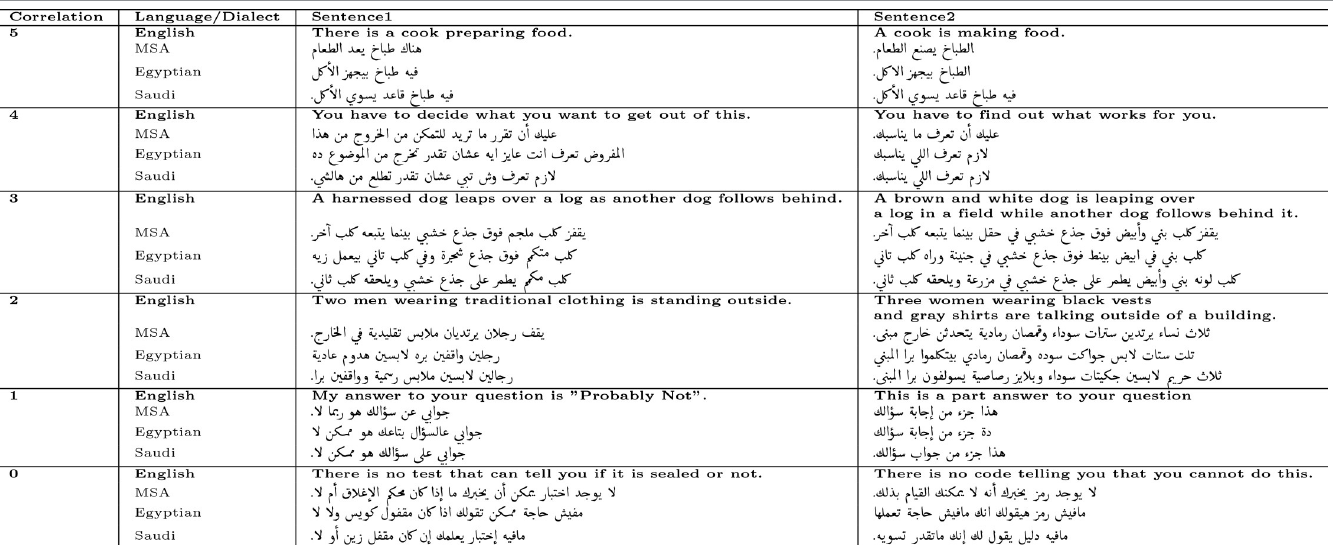
Table 2. Some examples of the proposed translations along with original English